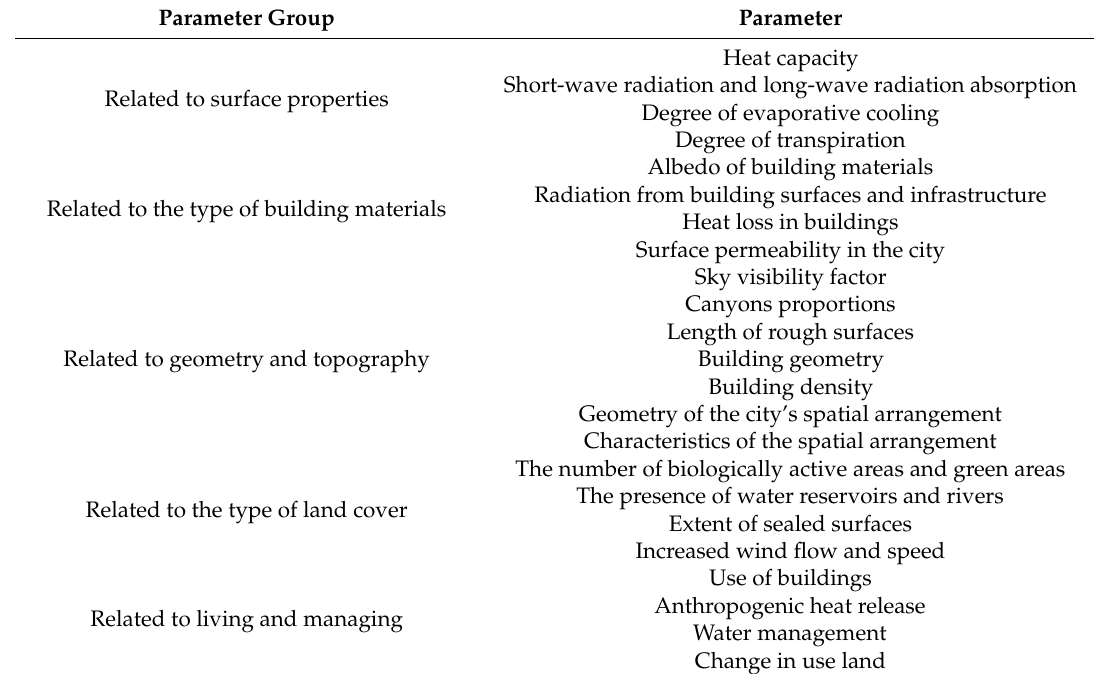
Table 1. Parameters a ff ecting Urban Heat Island (UHI) intensity that depend on the